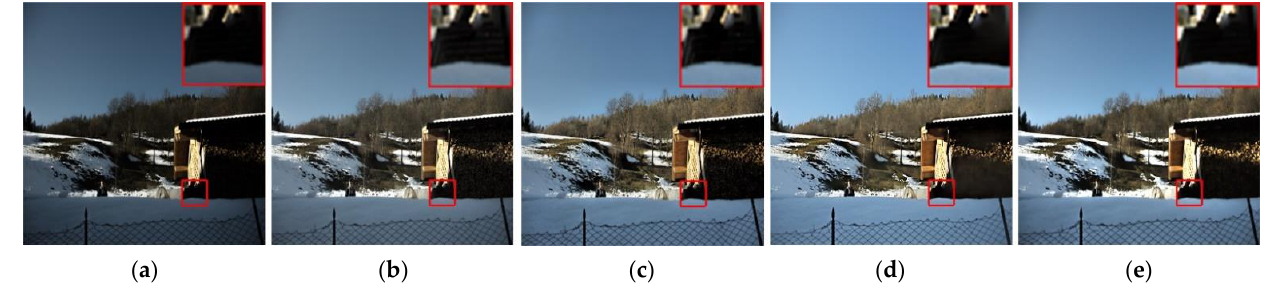
Figure 4. Experimental results of several methods in the darker areas of the image. ( a ) Original image; ( b ) BIMEF; ( c ) MEF; ( d ) SR; ( e ) SDD.